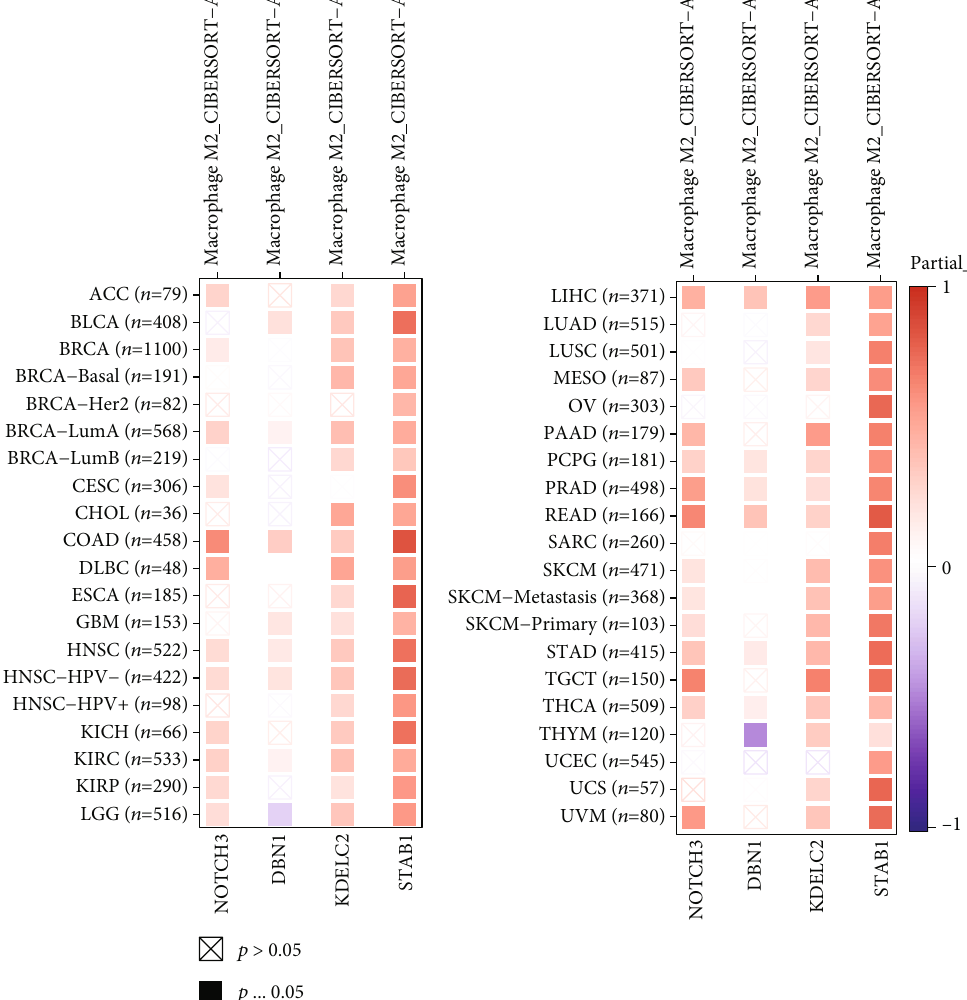
Figure 8: The correlation between NOTCH3, DBN1, KDELC2, and STAB1 and the M2 macrophage proportion in other cancer types was analyzed based on the TIMER database. In other types of cancer, the M2 macrophage proportion was also positively correlated in most cases, and STAB1 was most correlated with the M2 macrophage proportion in other types of